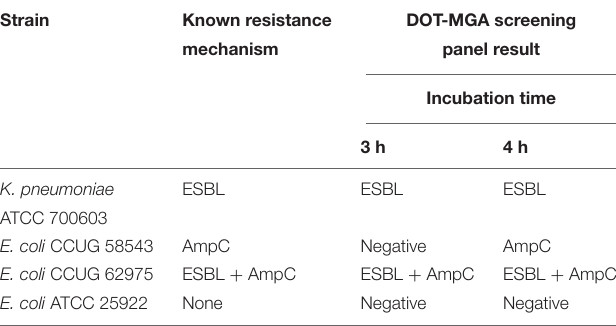
TABLE 1 | Detection performance of the DOT-MGA screening panel on reference strains recommended by EUCAST.